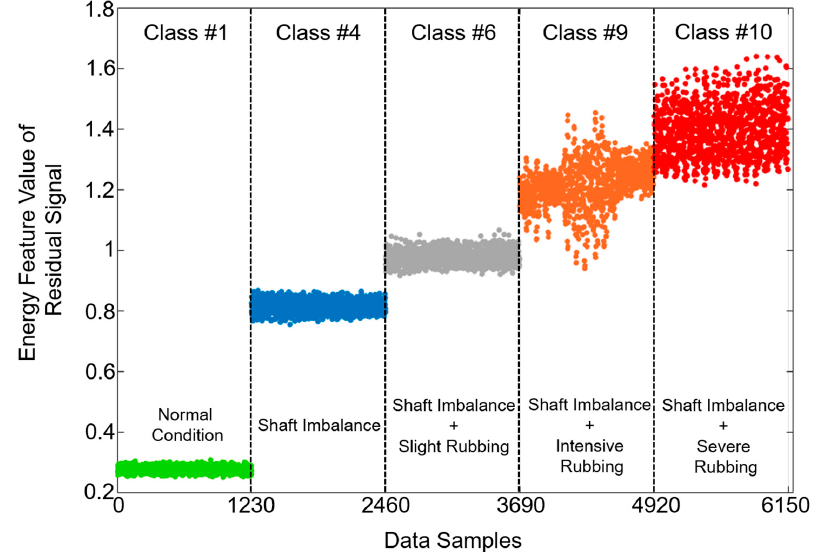
Figure 7. The energy feature parameter used for characterizing the residual signals obtained by proposed methodology for the signal classes under normal operating condition, 1.5 g shaft imbalance condition, 1.7 g shaft imbalance + slight blade-rub fault condition, 2.4 g shaft imbalance + intensive blade rub-fault, and 2.8 g shaft imbalance + severe blade rub fault, respectively.